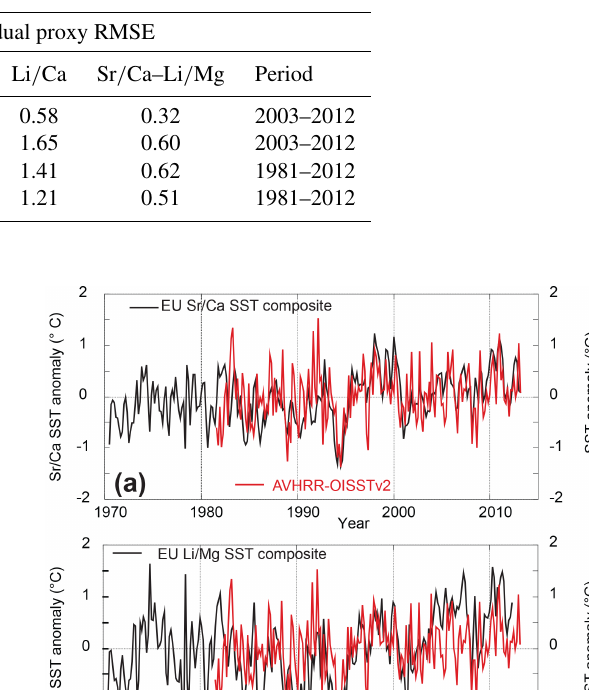
Table 3. Root mean square error (RMSE) for trace element ratios against AVHRR-OISSTv2 for individual trace element ratios and Sr / Ca– Li / Mg combination. Period used for the calculation of RMSE indicated in the last column.